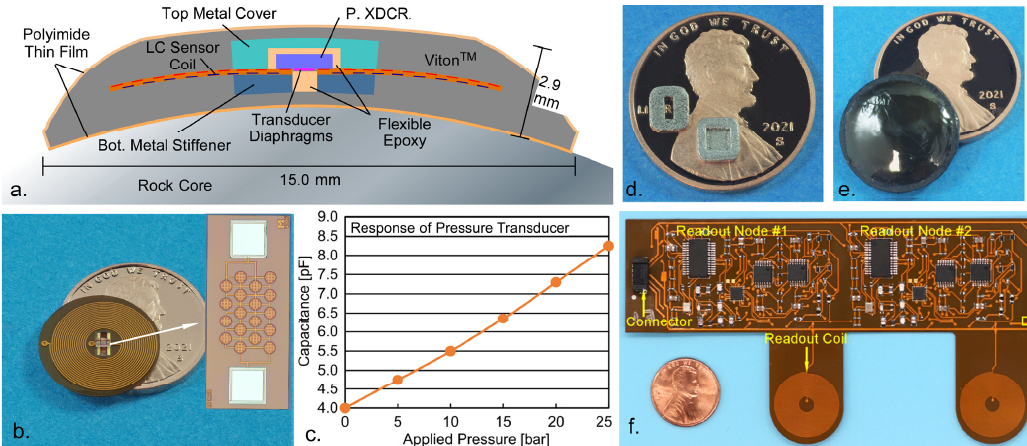
Figure 7. ( a ) Cross-section of packaged LC sensor. ( b ). Unpackaged LC sensor coil and inset image of capacitive pressure transducer. ( c ) Response of capacitive pressure transducer. ( d ). 3D printed bottom metal substrate stiffener (left) and top metal cover (right). ( e ) Fully packaged LC sensor. ( f ) Readout PCB showing two readout nodes.